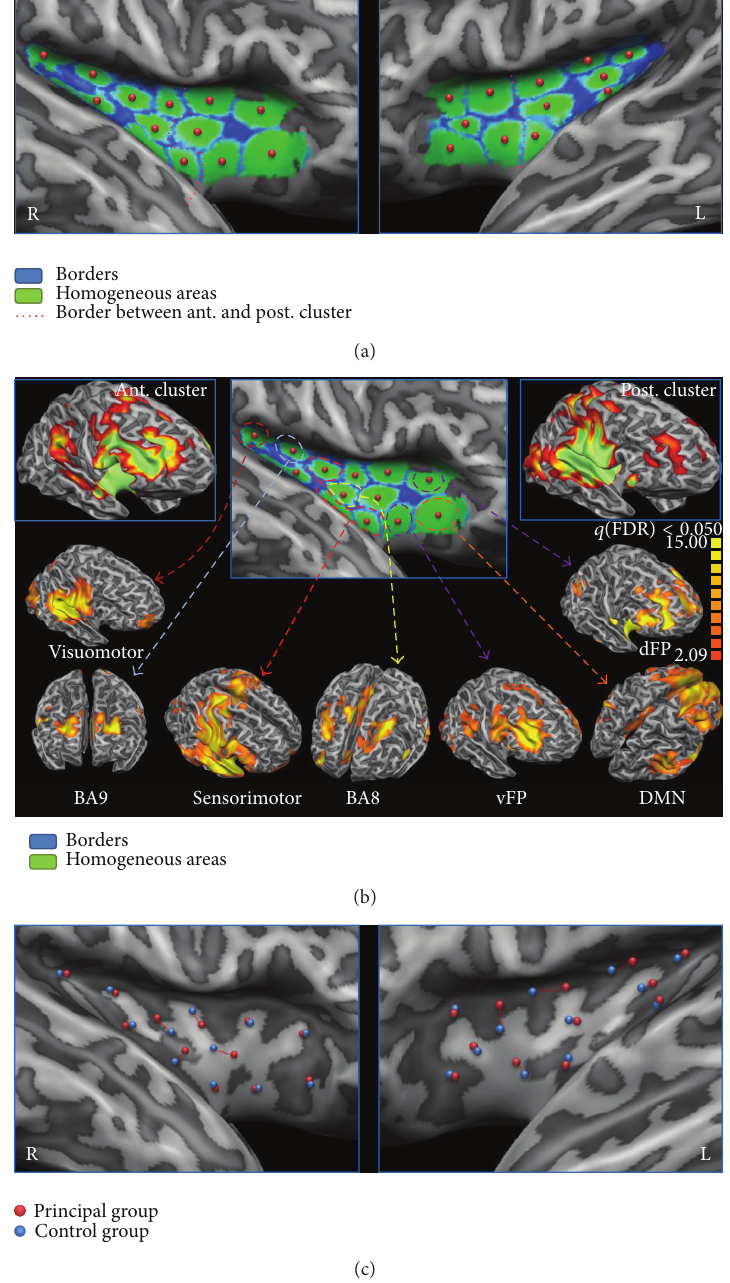
Figure 2: High-dimensional clusterization and node creation of the insular cortex. (a) High-dimensional insular clusterization. Homo- geneous areas are shown in green and borders in blue. The dotted red line outlines the separation between anterior and posterior clusters as detected in our previous studies [8, 33]. (b) Upper panels: anterior- and posterior-cluster functional connectivity. (b) Lower panels: patterns of functional connectivity regressing out the common variance. (c) Reliability of node creation. Nodes calculated from the main group are shown in red, nodes calculated from the replication group in blue. If separated, paired nodes are shown by a dotted red line.